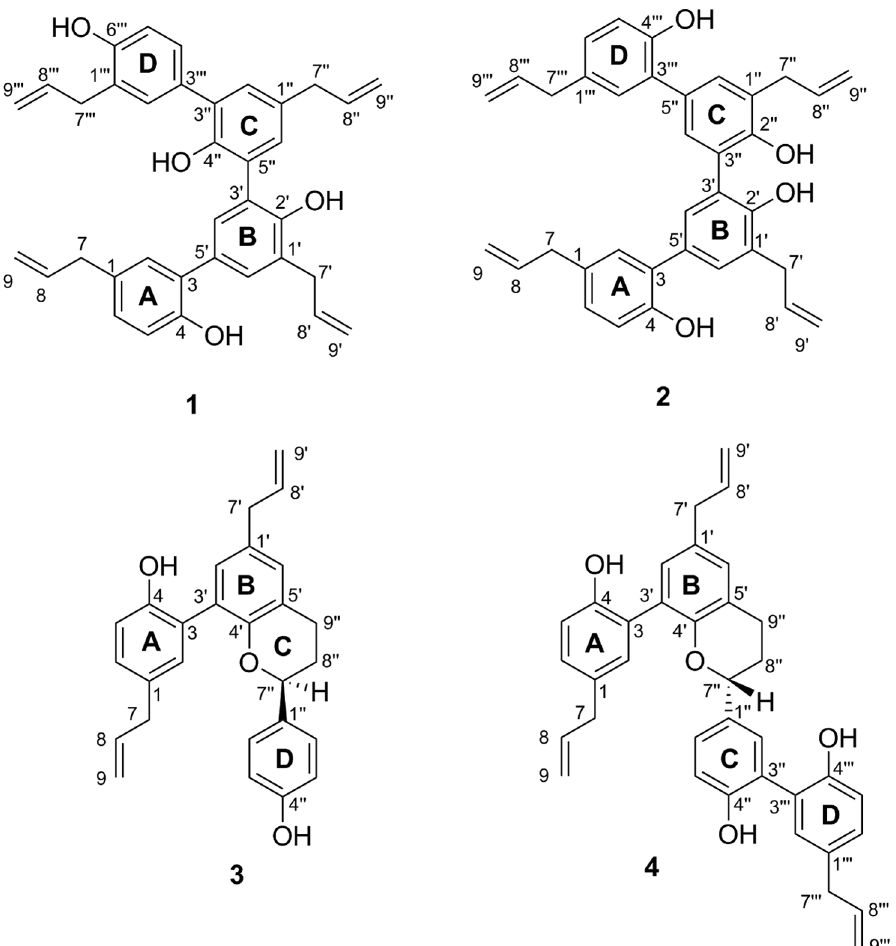
Figure 1. Structures of 1–4.